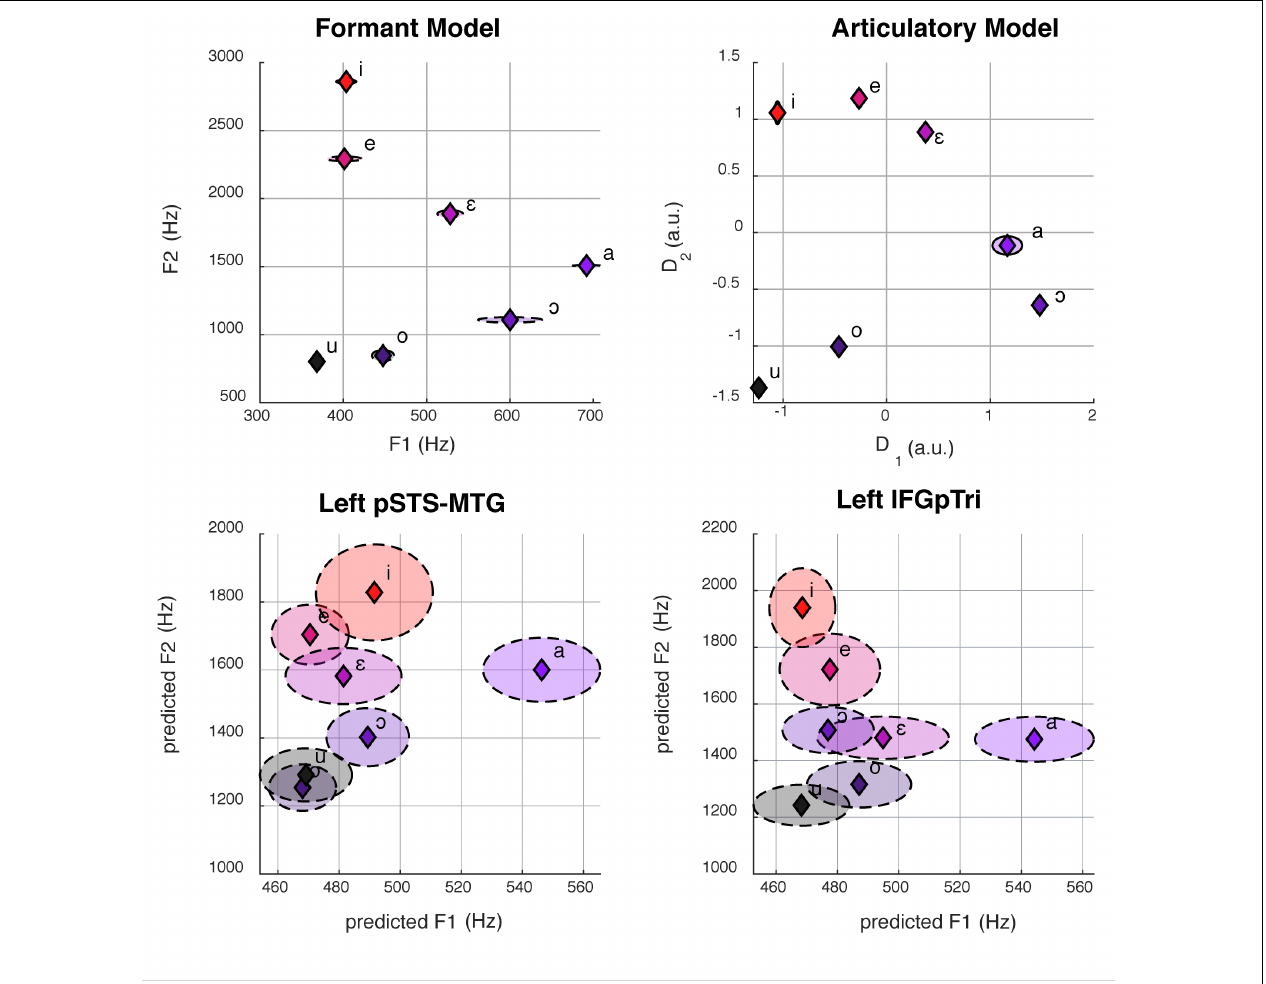
FIGURE 3 | Here we show formant space (top left) and articulatory space (top right) . The bottom panel shows the reconstruction of formant space (bottom left and right) from group-level brain activity in the left pSTS-MTG (center, R 2 = 0.40) and IFGpTri (right, R 2 = 0.39) through CCA. Dashed ellipses represent standard errors. Articulatory space reconstruction is not reported for lack of statistical